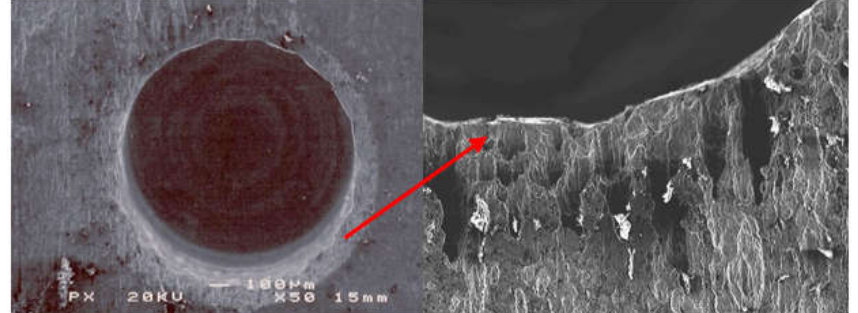
Figure 28. Corrosion around the flushing/hunting hole after 45 cycles (fracture). Scale = 100 μm. Sample #7.